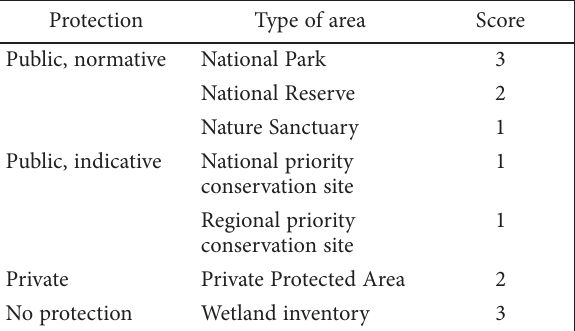
Table 2. Criteria for scores of high conservation value areas